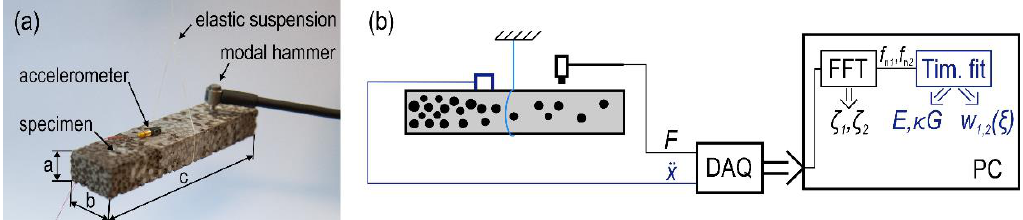
Figure 3. Experimental modal analysis of syntactic metal foams. Panel ( a ) shows the measurement configuration, while panel ( b ) illustrates the process of material parameter extraction (where DAQ is for data acquisition device, and FFT is for Fast Fourier Transformation and Time. Fit is for time fitting).